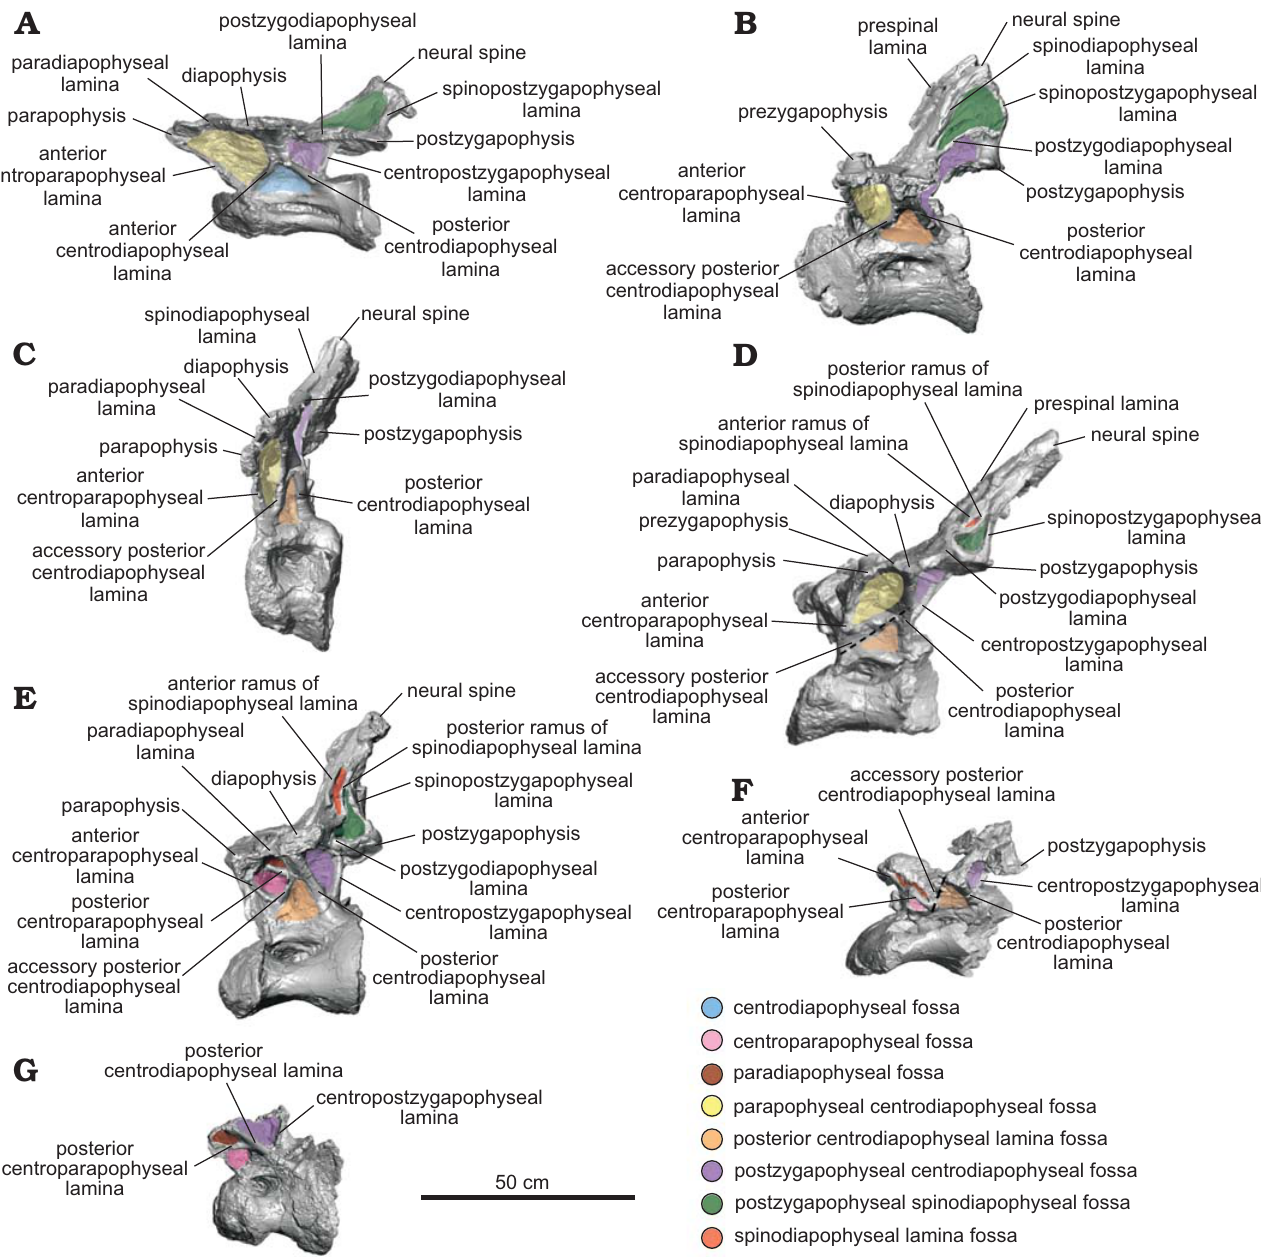
Fig. 1. Nearly complete dorsal vertebrae of titanosaurian sauropod Dreadnoughtus schrani Lacovara, Lamanna, Ibiricu, Poole, Schroeter, Ullmann, Voegele, Boles, Carter, Fowler, Egerton, Moyer, Coughenour, Schein, Harris, Martínez, and Novas, 2014, from Santa Cruz Province, Argentina; middle–late Campanian to early Maastrichtian; in left lateral view. A . MPM-PV 1156?-4, estimated as the ~4 th dorsal vertebra. B . MPM-PV 1156?-5, ~5 th . C . MPM-PV 1156-6, ~6 th . D . MPM-PV 1156?-8, ~7 th . E . MPM-PV 1156?-9, ~8 th . F . MPM-PV 1156?-10, ~9 th . G . MPM-PV 1156-11, ~10 th . Dashed lines indicate frac- tured neural arch laminae. Colours indicate neural arch